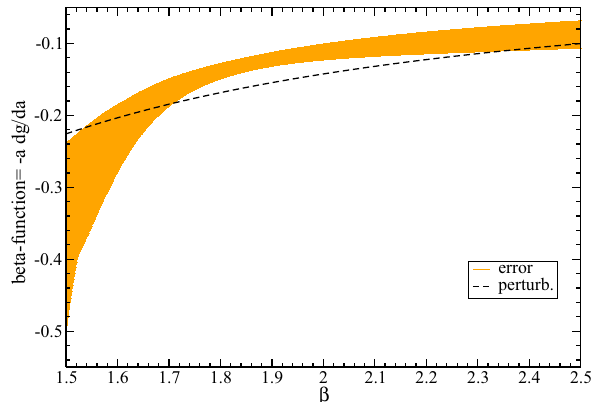
Fig. 8 Plot β -function: final uncertainty